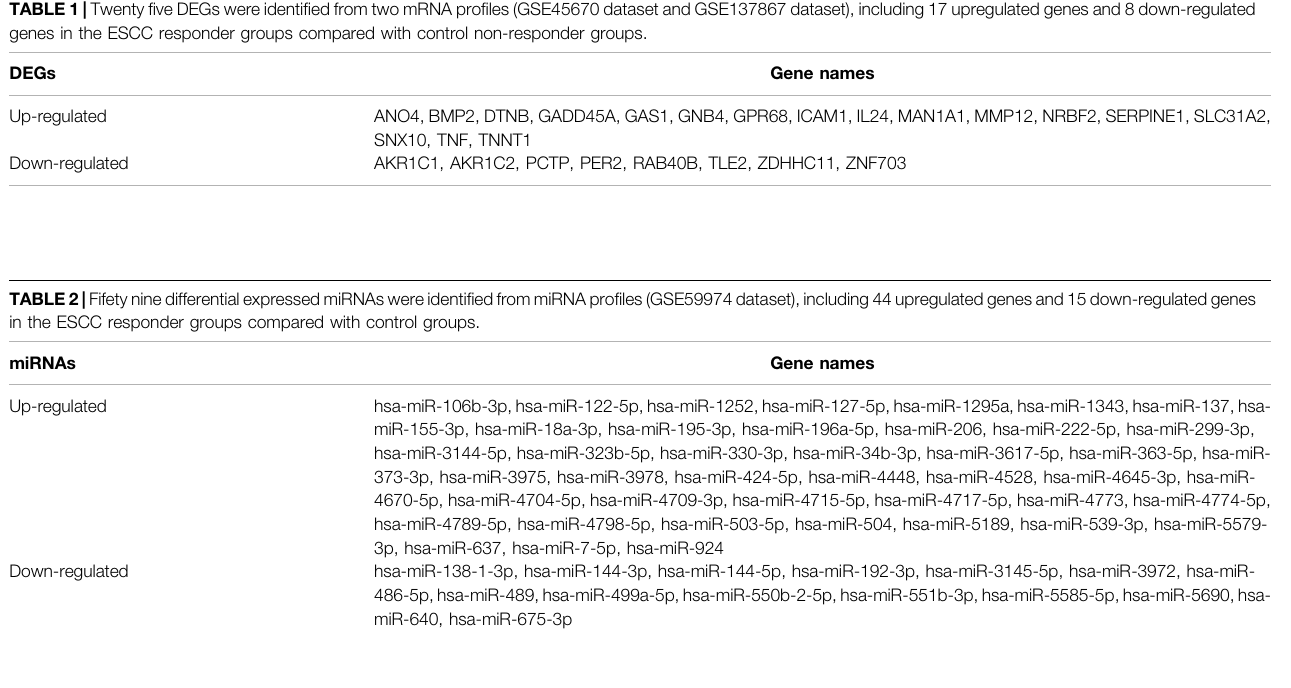
Frontiers in Pharmacology |